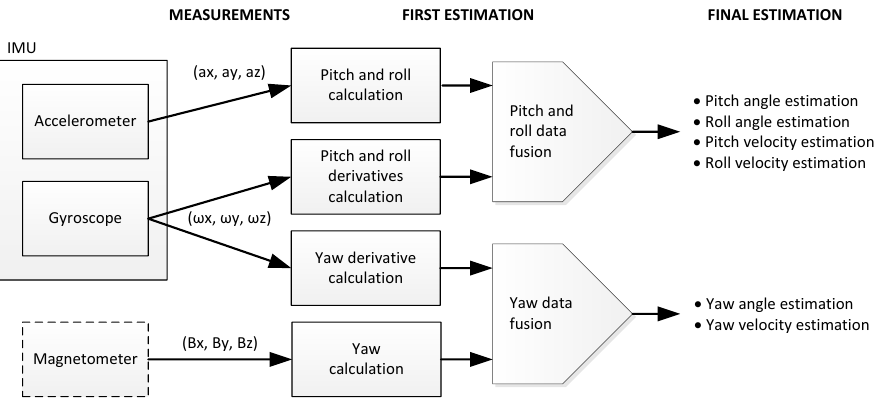
Figure 16. Data fusion between accelerometer, gyro and magnetometer to estimate roll, pitch and